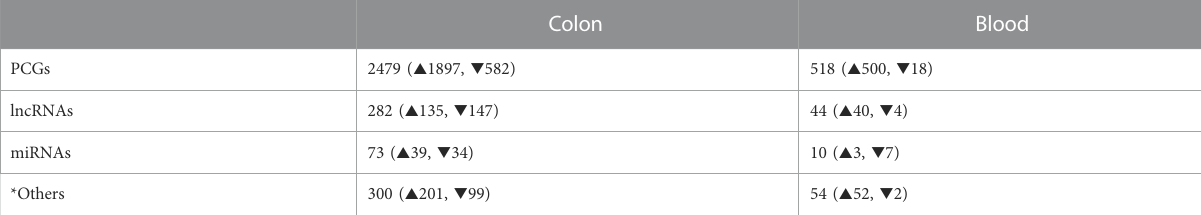
TABLE 1 Numbers of SDE genes identi fi ed in colon and blood of DSS-UC mice versus control. (For PCGs and lncRNAs |log2FC| > 1, padj ≤ 0.05 and for miRNAs FC > 1.5, padj ≤ 0.05).